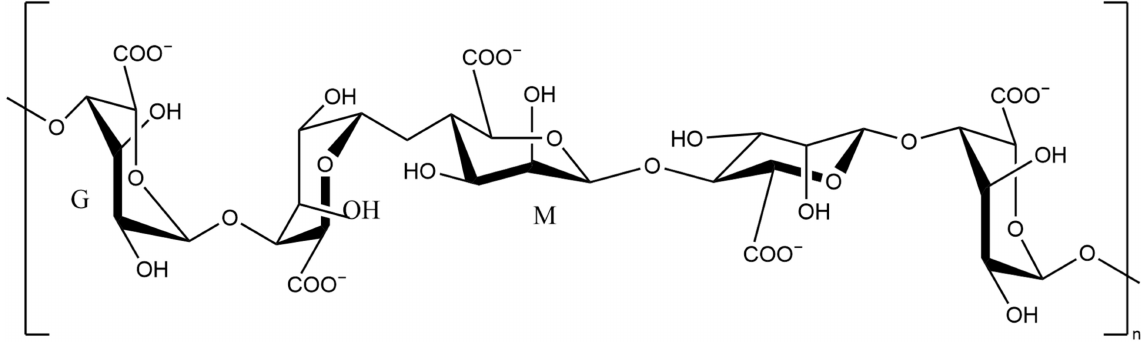
Figure 6. Chemical structure of alginate